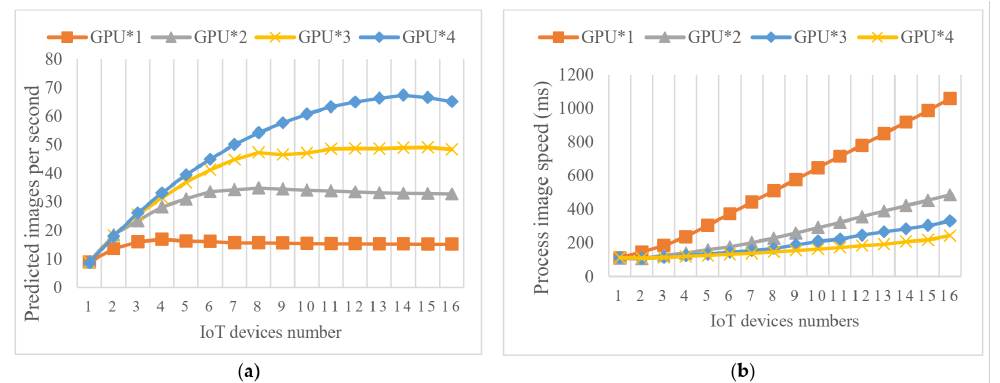
Figure 10. Performance test results: ( a ) analyzed images per second and ( b ) image processing speed in milliseconds.